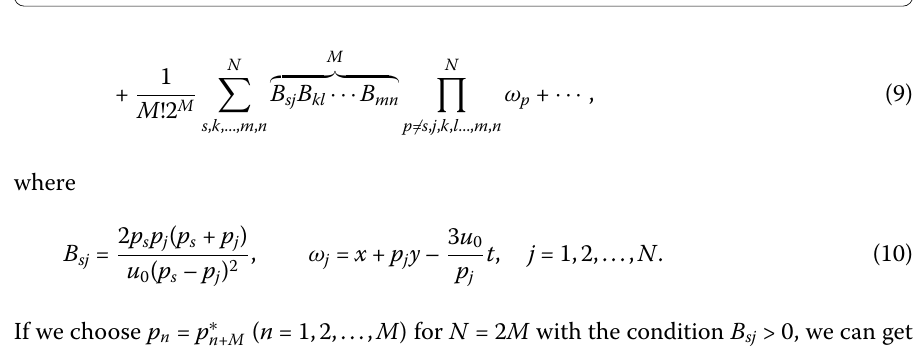
Figure 1 One-lump solution with parameters p 1 = p ∗ 2 = 1 + i at t = 0. (a) Surface (top) and density (bottom) plots of one lump; (b) the corresponding counter plot of